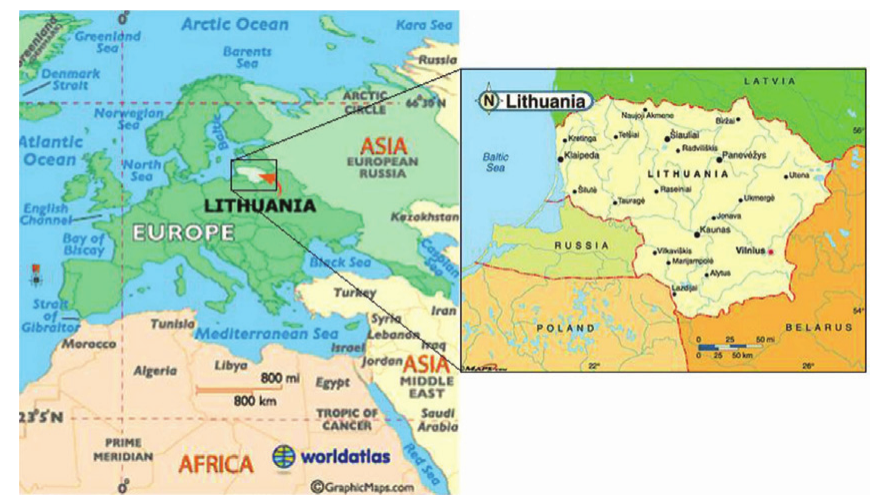
Fig. 1. Location of Lithuania in the world map (Laurinavičius et al.